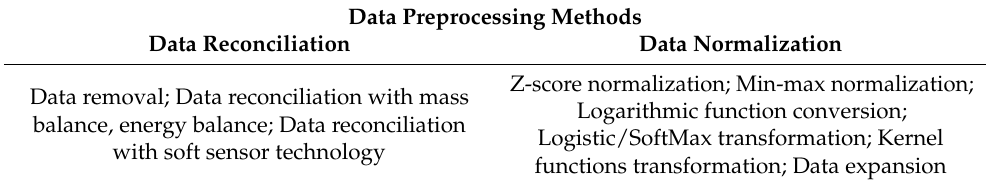
Table 1. A summary of data preprocessing methods.